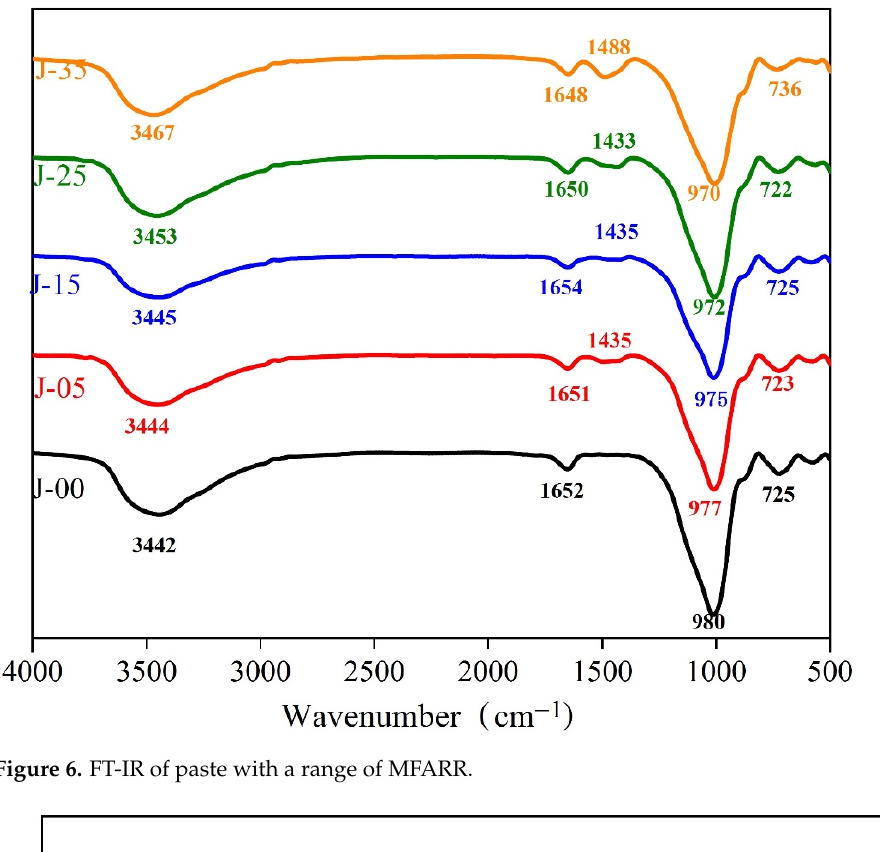
Figure 6. FT ‐ IR of paste with a range of MFARR. Figure 6. FT-IR of paste with a range of MFARR.